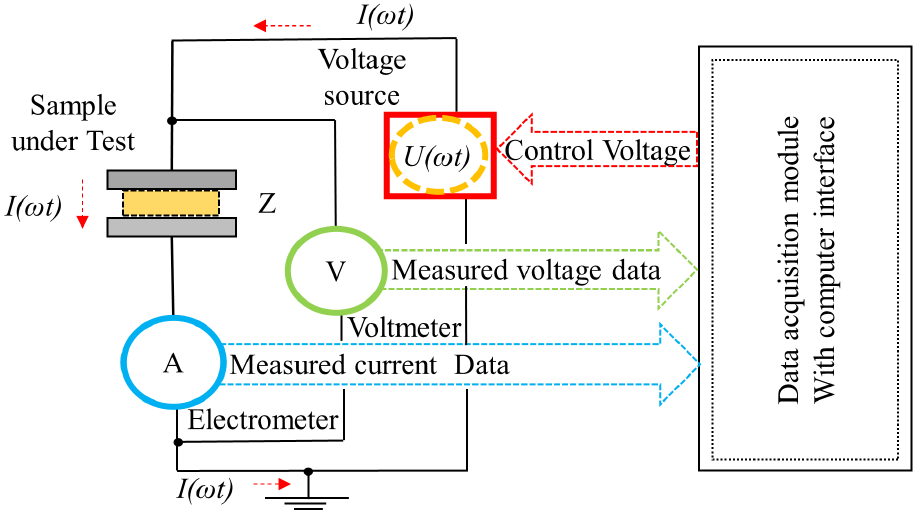
Figure 1. Schematic diagram of the dielectric frequency domain spectroscopy (DFDS) system.